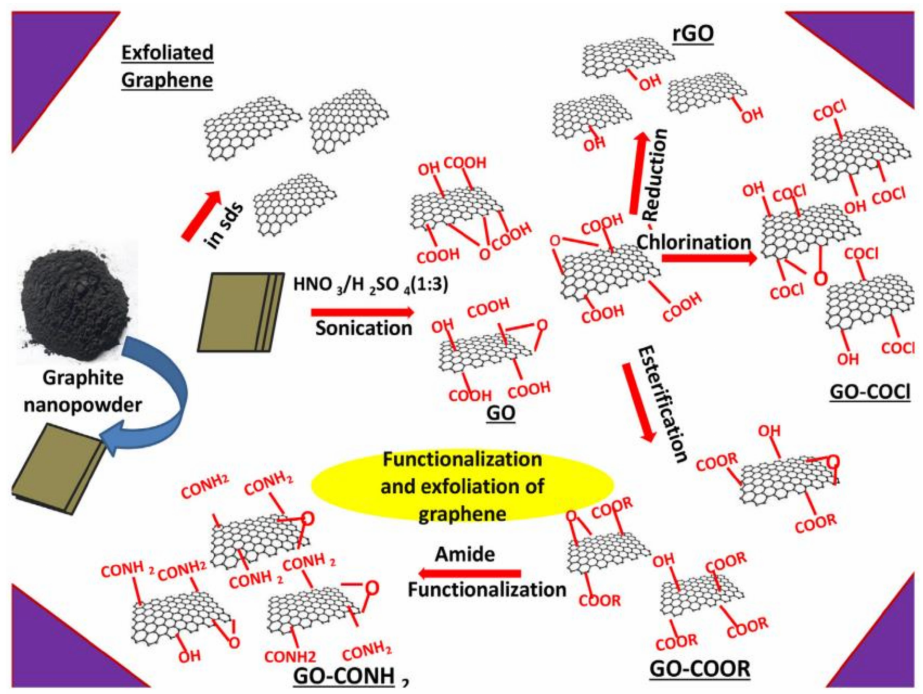
Figure 7. The schematic representation summarizing the chemical reactions performed for functionaliza- tion. (Reproduced from [132] with permission. Copyright 2015, Elsevier, Amsterdam, The